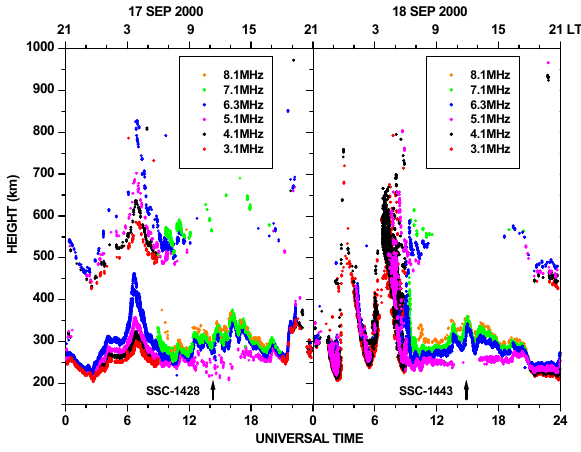
Fig. 2b. The variations of vertical heights at different fixed fre- quencies observed at Sao Jose dos Campos on 17 and 18 September